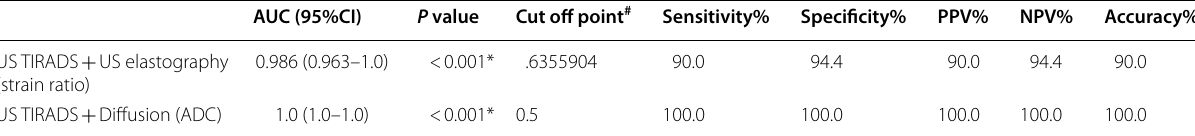
# Detected through multivariate